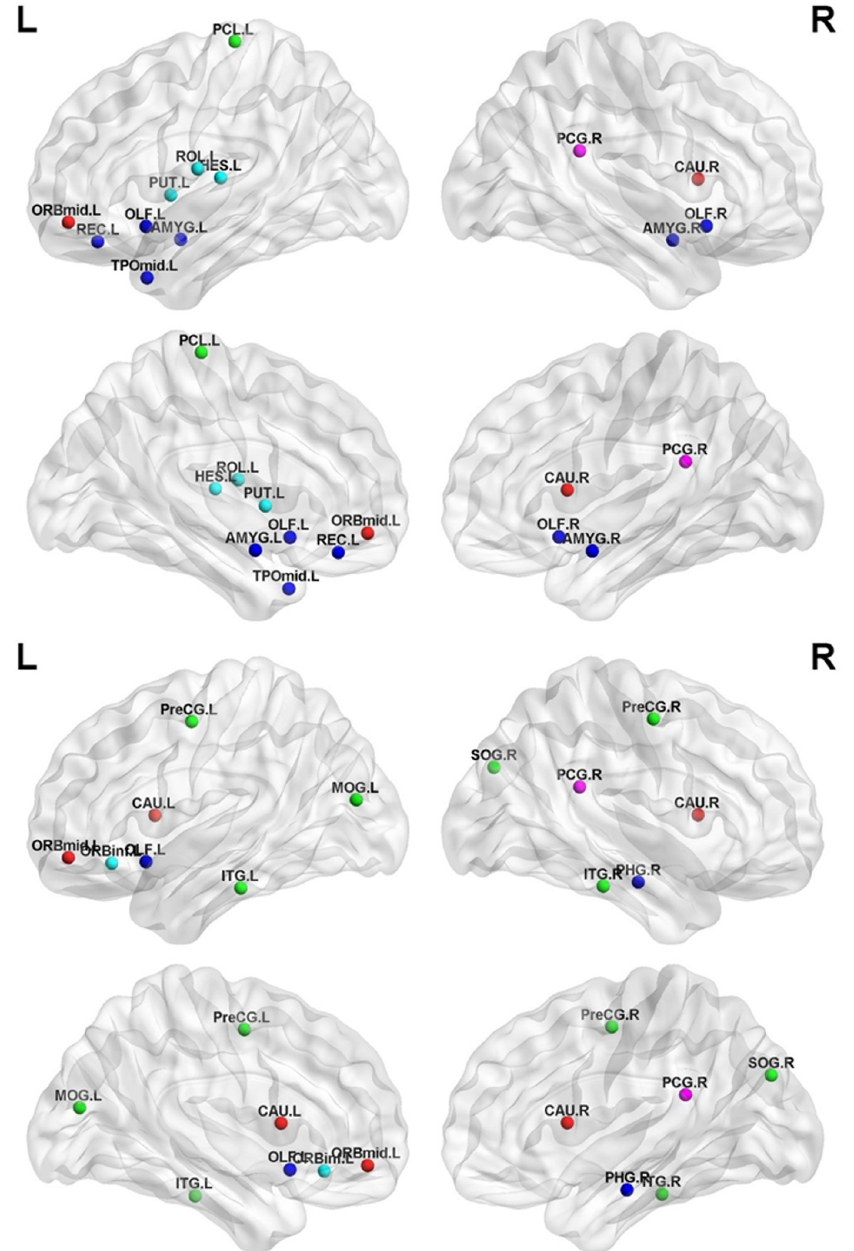
Fig 4. Hubs of the functional brain networks in each group. The results were visualized using the BrainNet Viewer (NKLCNL, Beijing Normal University). The maps showed the hubs of the brain network in normal controls (top panel) and in PD patients (bottom panel). Colors in nodes indicate different modules. Detailed brain region information corresponding to the anatomical labels can be found in S1 Table.